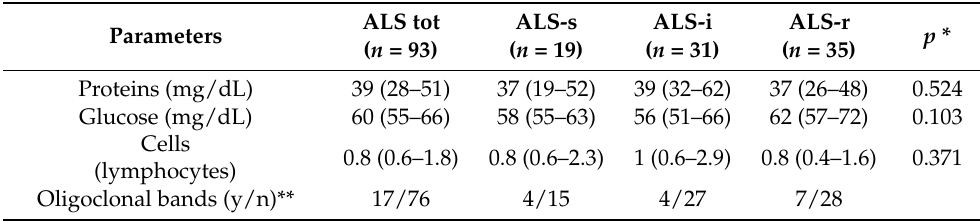
Table 2. Cerebrospinal parameters in ALS patients and in patients with slow (ALS-s), intermedi- ate (ALS-i) and rapid (ALS-r) progression. Data are expressed as a median with an interquartile range